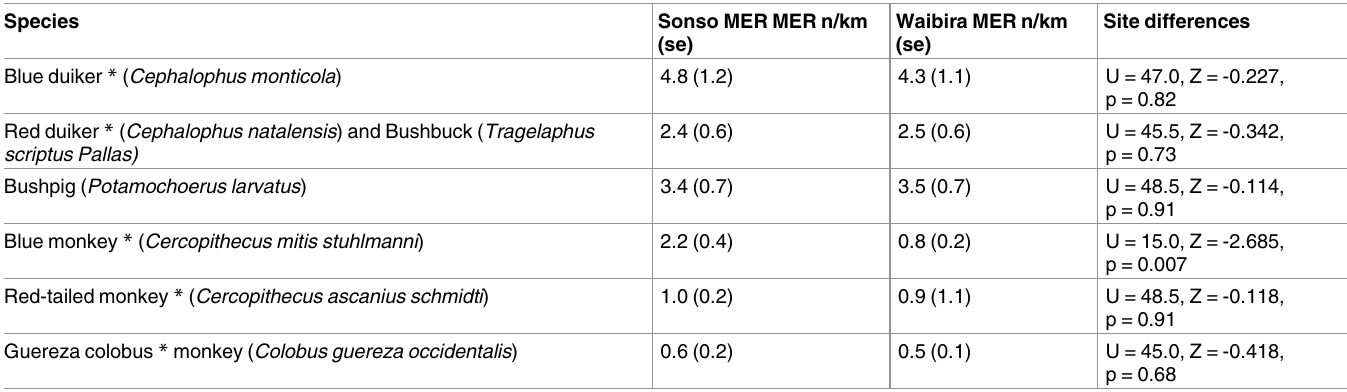
Fig 1. Variation in month-to-month hunting of colobus and non-colobus prey by the Sonso chimpanzees. Monthly rates in panel A and B were calculatedby calculatingthe huntingrate per month for each year, and then averagingacross these to control for year-to-year variation within the data sets. Panel A shows the huntingbehaviourin the 9-year periodfrom 1999–2007inclusive;Panel B shows the huntingbehaviour in the 9-year periodfrom 2008–2016 inclusive.Panel C and D show the colobusand non-colobus huntingbehaviour respectivelyin the 9-year periodfrom 2008–2016 for each individualyear (note that here the axis represents total hunts per month across the 9 years, rather than mean hunts per month, to allowyear to year comparison). https://doi.org/10.1371/journal.pone.0178065.g001 Table 2. Mean encounter rate of potential prey